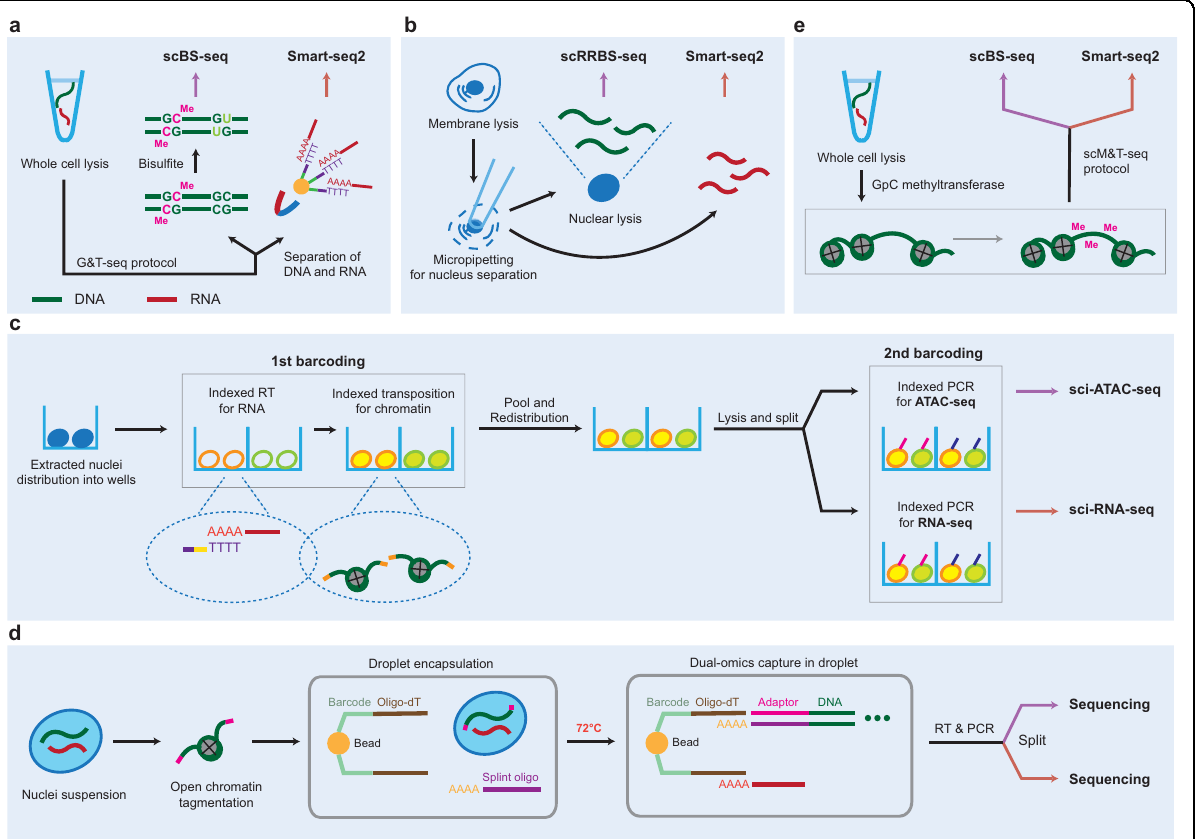
Fig. 3 Single-cell multiomics sequencing protocols for the integrative analysis of the transcriptome and epigenome. Protocols for the isolation of single cells or nuclei and the barcoding of gDNA and mRNAs are shown for fi ve types of multiomics analyses of the transcriptome and epigenome: scM&T-seq ( a ) and scMT-seq ( b ) for DNA methylation and sci-CAR ( c ), SNARE-seq ( d ), and scNMT-seq ( e ) for chromatin accessibility. Gray cross, nucleosome; Me, CH 3 . In c , the colors of the border line, inside, and tip of the circles distinguish the barcodes of mRNAs, accessible DNA fragments, and indexed PCR, respectively. See the legend in Fig. 2 for the other symbols and the text for the de fi nitions of the